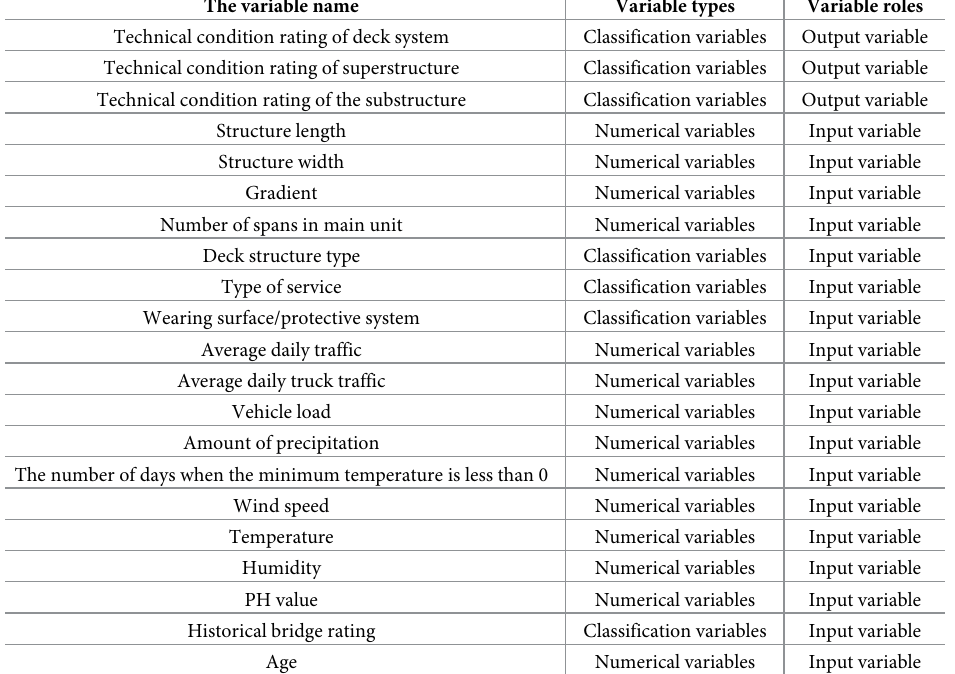
Table 3. Variable types and